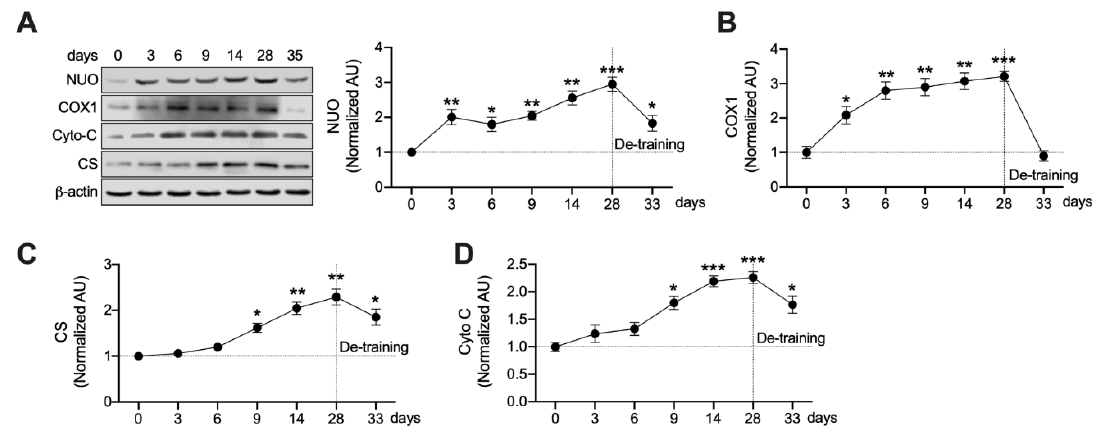
Figure 4. Differences in the normalization rates of mitochondrial proteins. ( A and B ) NUO and COX 1 are rapidly upregulated by Ext; however, only NUO is stable after 5 days of de-training ( n = 6 muscles of rats per each day). Values are means ± SE. * p < 0.05, ** p < 0.01, *** p < 0.001 versus day 0. ( C ) and ( D ) CS and Cyto C are gradually upregulated by Ext and stabilize after 5 days of de-training ( n = 6 muscles of rats per each day). Values are means ± SE. * p < 0.05, ** p < 0.01, *** p < 0.001 versus day 0. Significance was determined using one-way ANOVA.